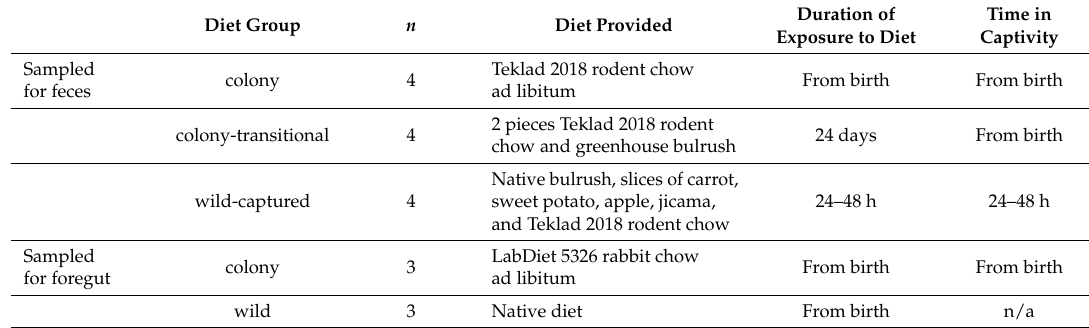
Table 1. Summary of diet treatments provided to study